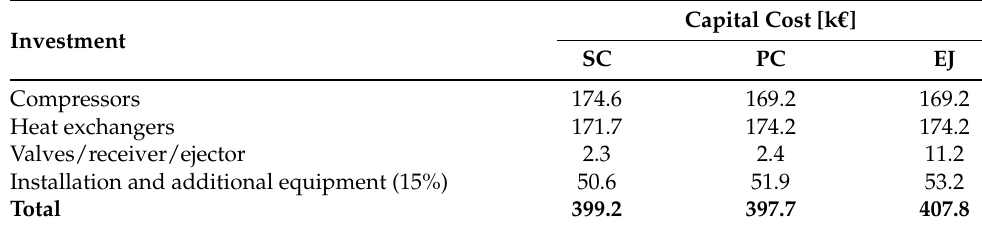
Figure 11. Annual energy savings and reduction in related emissions (TEWI) of SC design in relation to the reference thermal system. The eight selected locations are investigated when applying both the leveled and aggressive charging strategy. Table 6. Total equipment investment cost of the CO 2 designs with single-stage compression (SC), parallel compression (PC), and ejector-supported parallel compression